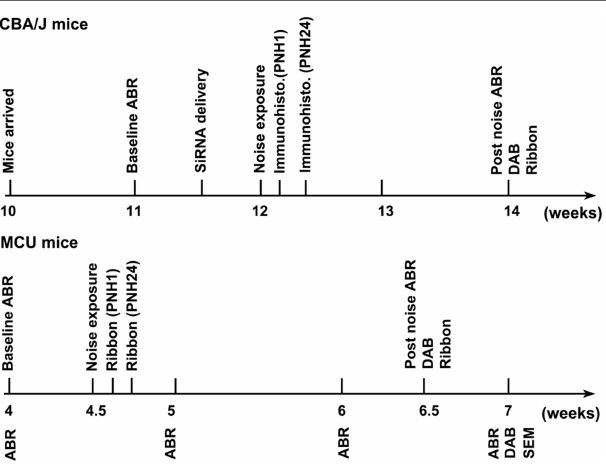
TABLE 1 | Experimental time